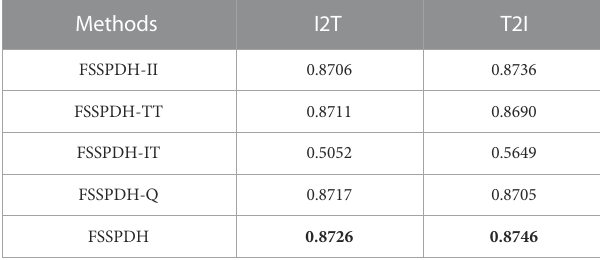
TABLE 4 Ablation results of our FSSPDH approach on the MIRFlickr